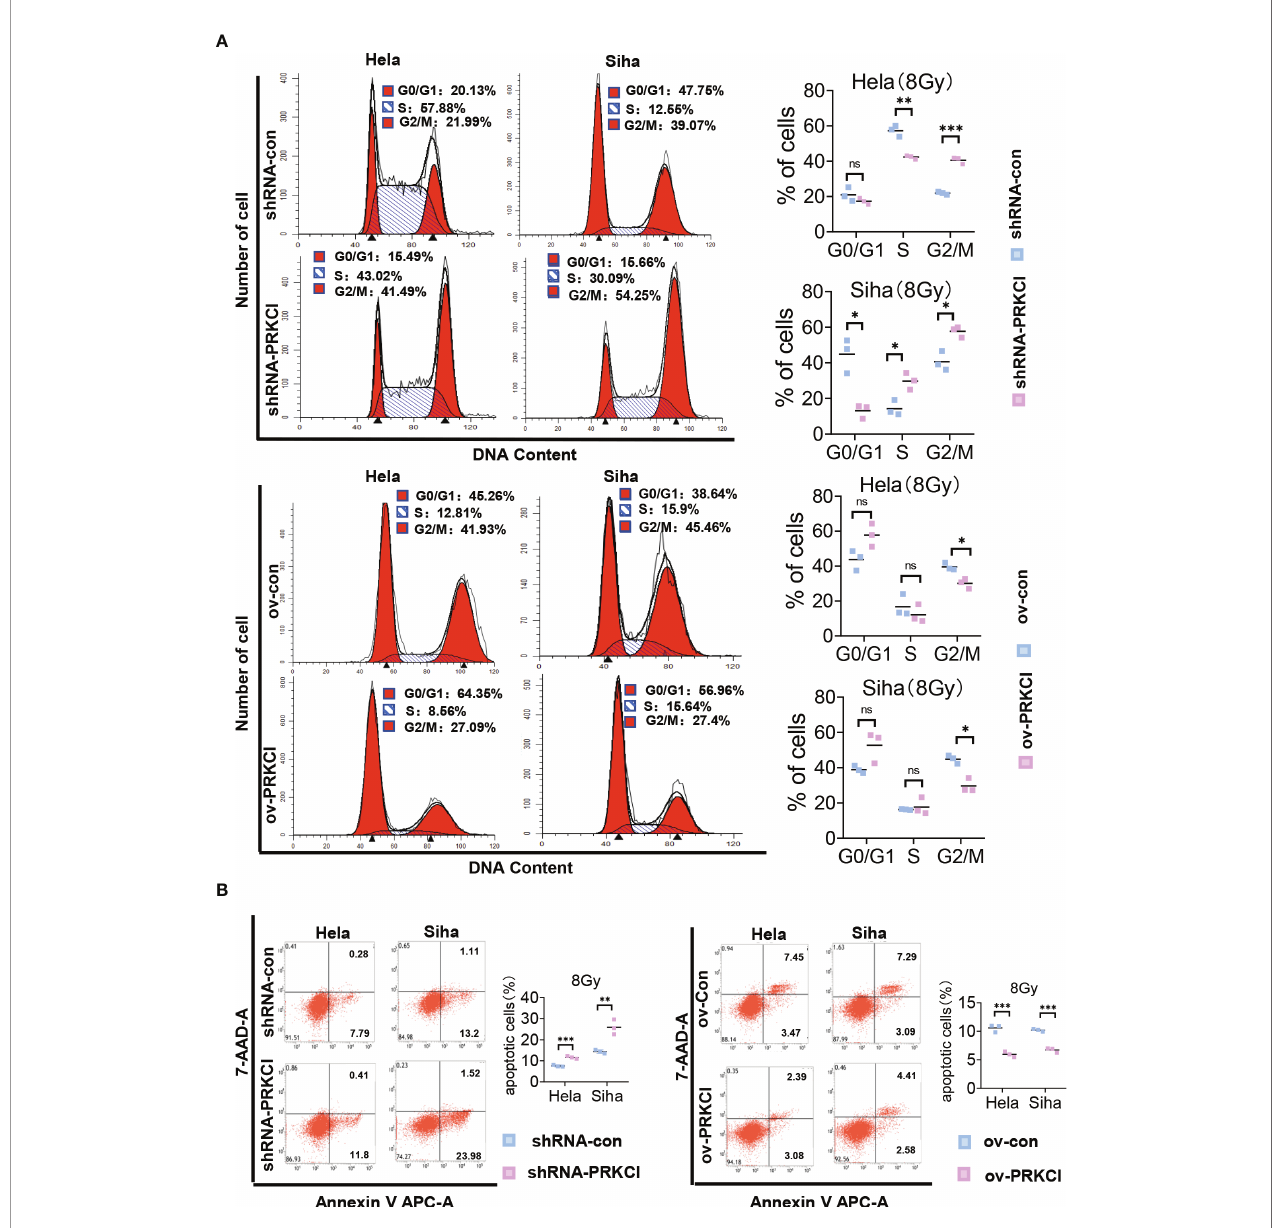
FIGURE 3 | In fl uence of PRKCI suppression and overexpression on radiosensitivity in CC cells in cell cycle and apoptosis. (A) PRKCI decreases the G2/M population of CC cells treated with radiotherapy. (B) PRKCI decreases apoptosis of CC cells treated with radiotherapy. Data are shown as the mean from three independent experiments (A, B) . *p < 0.05; **p < 0.01; ***p < 0.001 by unpaired t-tests (A, B) . ns, not signi fi cant. CC, cervical